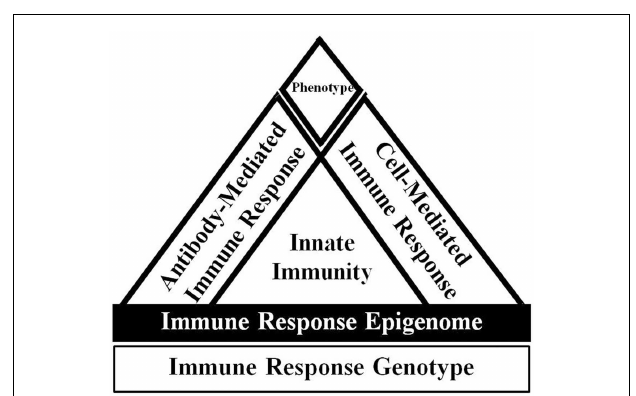
FIGURE 1 | Overview of immune response adapted from Ref. (105) .The host immune response phenotype is ultimately determined by the interaction of the immune response genotype with the environment.The expression of the immune response genotype is also regulated by epigenetic effects.The innate immune response is relatively fast acting and non-specific, but is critical to signal appropriate adaptive cell-mediated and antibody-mediated immune responses. Dairy cattle with enhanced and balanced cell and antibody-mediated immune responses are known as high immune responders.